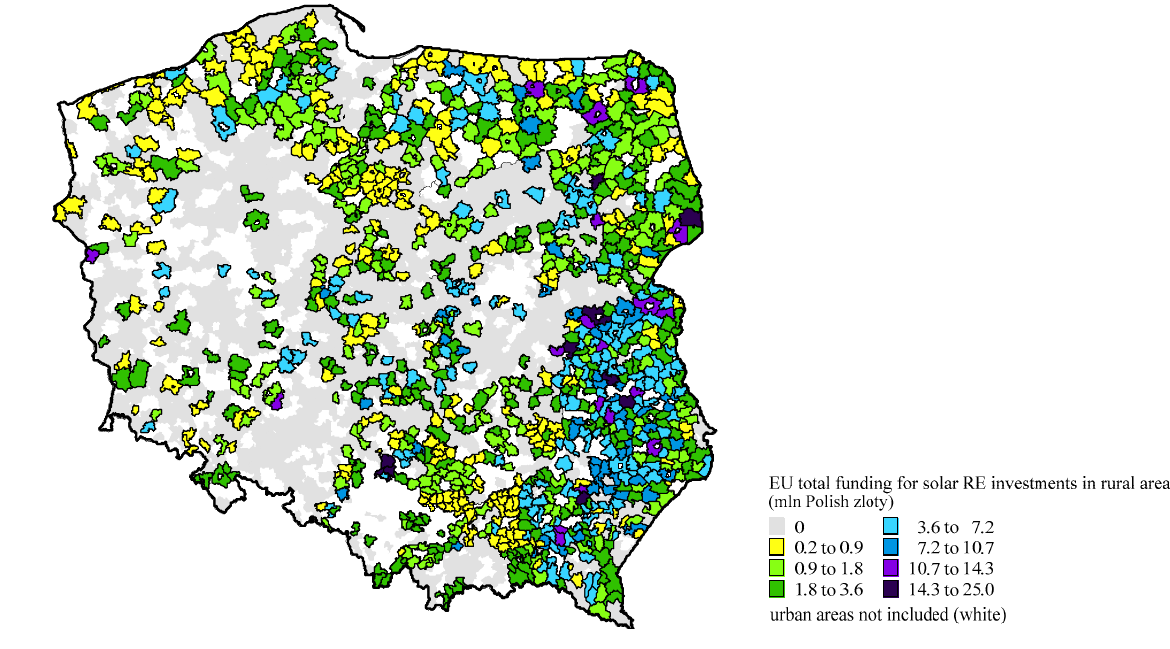
Figure 2. Total value of EU funds for solar RE investments in rural areas under operational pro- grammes in 2014–2020, mln Polish zloty, as of 31 May 2021.